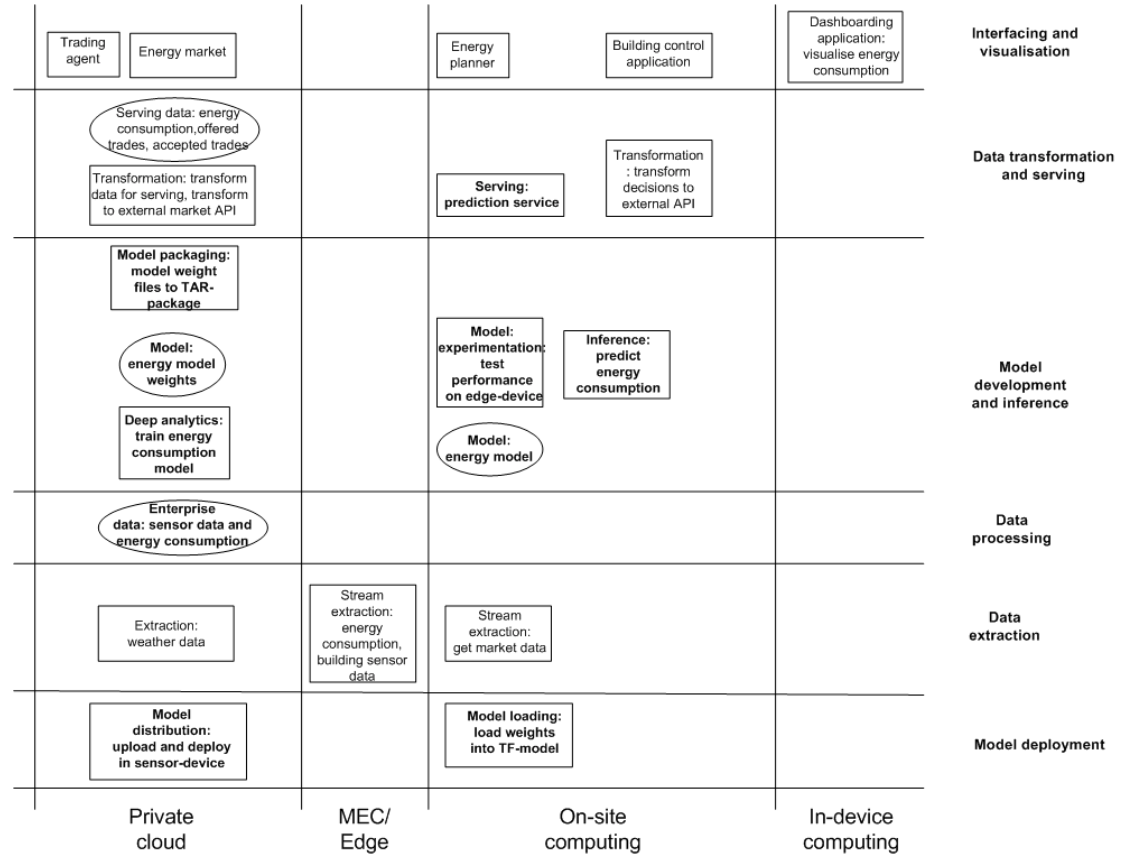
Figure 3. Deployment environment view of the architecture. The architectural elements from functional areas (Y-axis) have been mapped to different deployment environments (X-axis). The implemented elements have been described in bold.